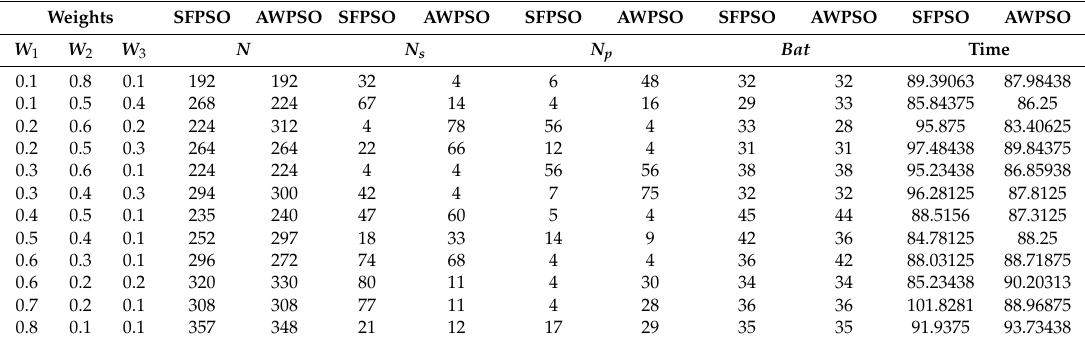
Table 4. Di ff erent weights sets and optimal configurations of the SAPV system.